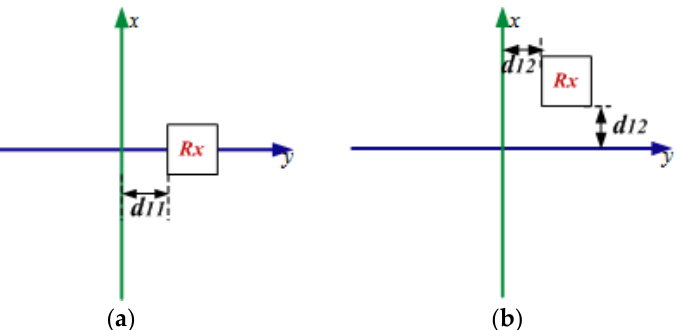
Figure 10. The Rx coils in different topology positions of the STSR WPT system, ( a ) case5 and ( b ) case 6.